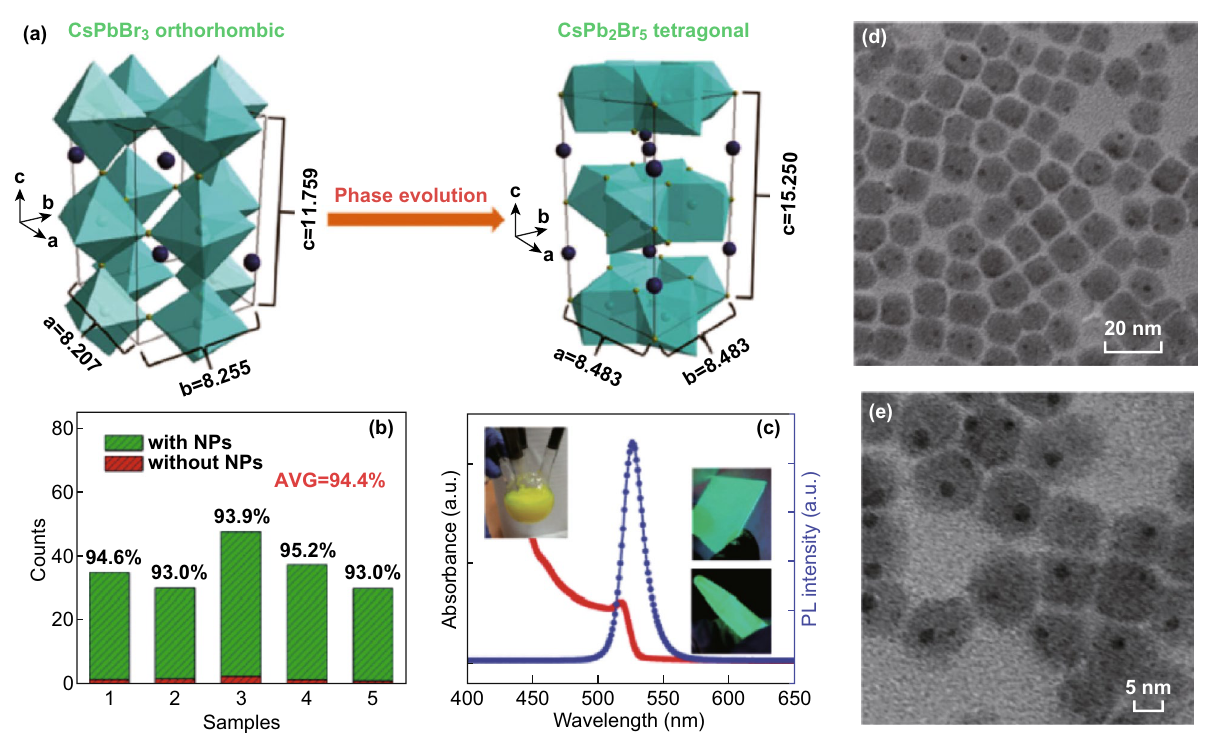
Fig. 2 a Crystal structure schematics of the orthorhombic CsPbBr 3 and tetragonal CsPb 2 Br 5 (blue ball: Cs + ). The unit of all the cell parameters is Å. Reprinted with permission from Ref. [22]. Copyright 2016 Royal Society of Chemistry. b The percentage of the CsPbBr 3 nanocrystal being covered by CsPb 2 Br 5 nanoparticles and their PL quantum yield (PLQY). c Absorption and PL spectra of CsPb 2 Br 5 /CsPbBr 3 composites. The inset shows as-obtained products in four-necked flask and light emission of CsPb 2 Br 5 /CsPbBr 3 deposited on the glass and tube excited with ultraviolet light. d – e TEM images of all-inorganic CsPb 2 Br 5 /CsPbBr 3 nanocomposite at different magnifications. Dark dots in e are CsPb 2 Br 5 nanoparticles. Reprinted with permission from Ref. [21]. Copyright 2016